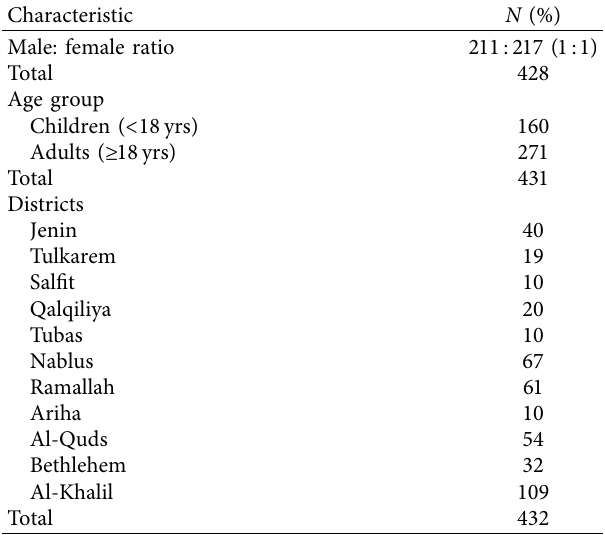
Table 1: The general characteristics of the study population.